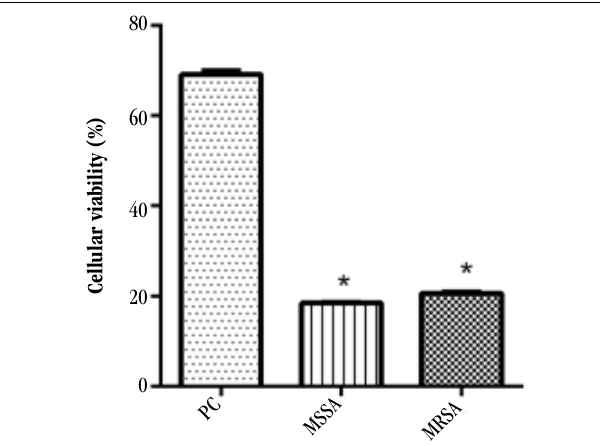
NC, MSSA and MRSA systems after one and two-hour incubation periods. Values expressed as mean ± standard error ( n = 20) *: p < 0.05 between 1h and 2h for NC, MSSA and MRSA.